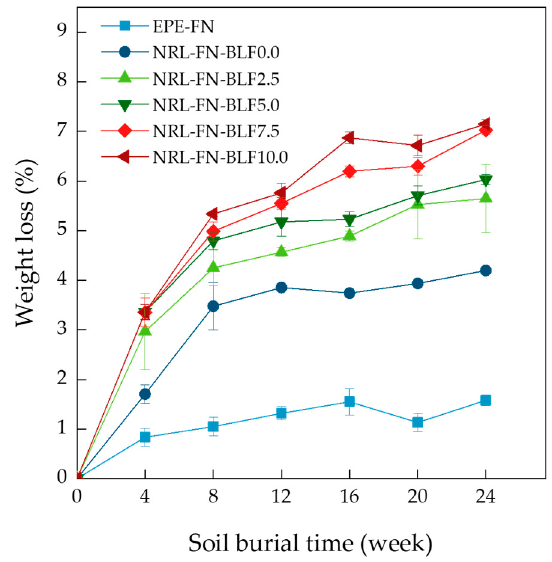
Figure 13. Weight loss percentage of EPE-FN, NRL-FN, and NRL-FN-BLFs cushion foams at various BLF contents over 24 weeks of soil burial times.